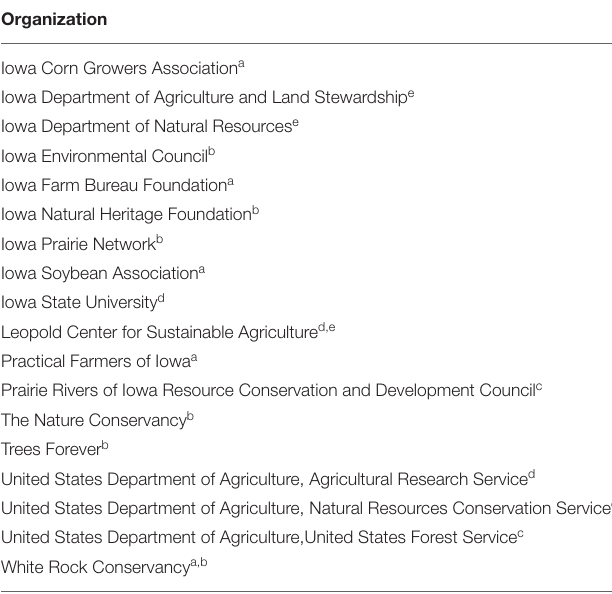
TABLE 1 | Organizations represented in the Delphi case